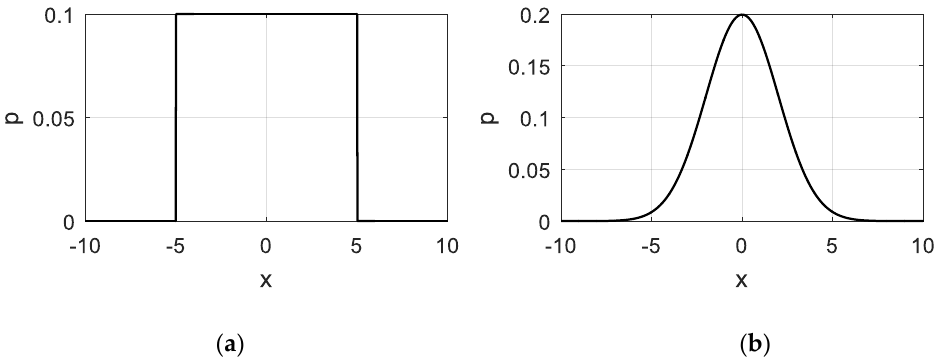
Figure 4. Probability density function: ( a ) rand( – 5,5); ( b ) N~(0, 2 2 ).